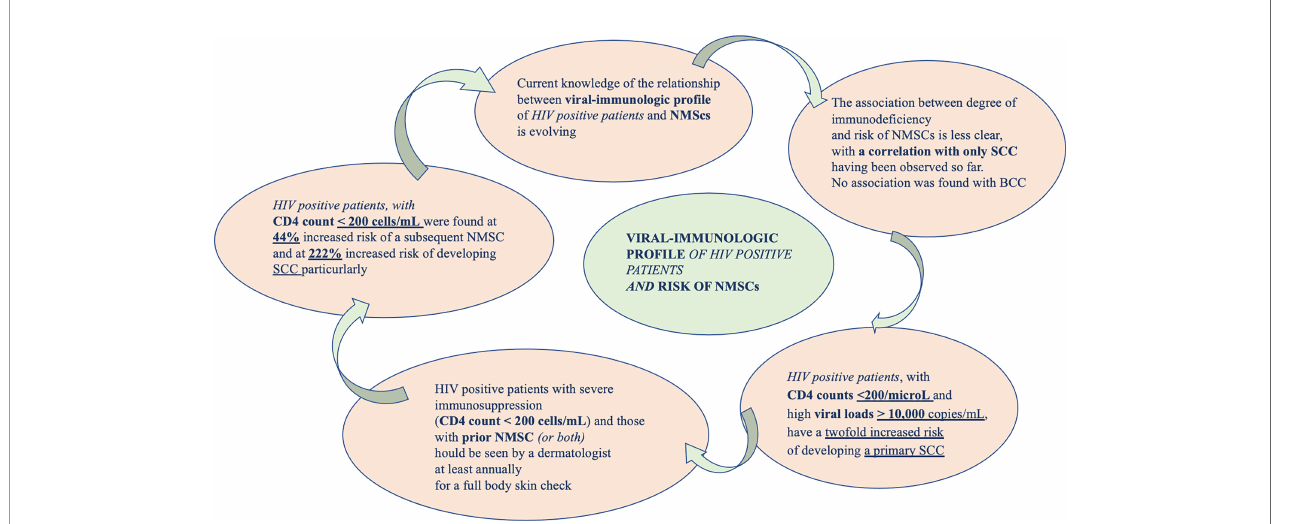
FIGURE 3 | The exploration of a bond between NMSCs and immuno-viral pro fi le of